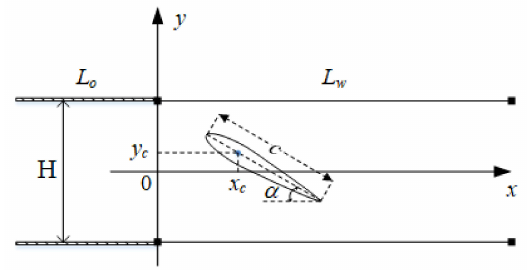
Figure 6. The position of the airfoil in the jet flow.